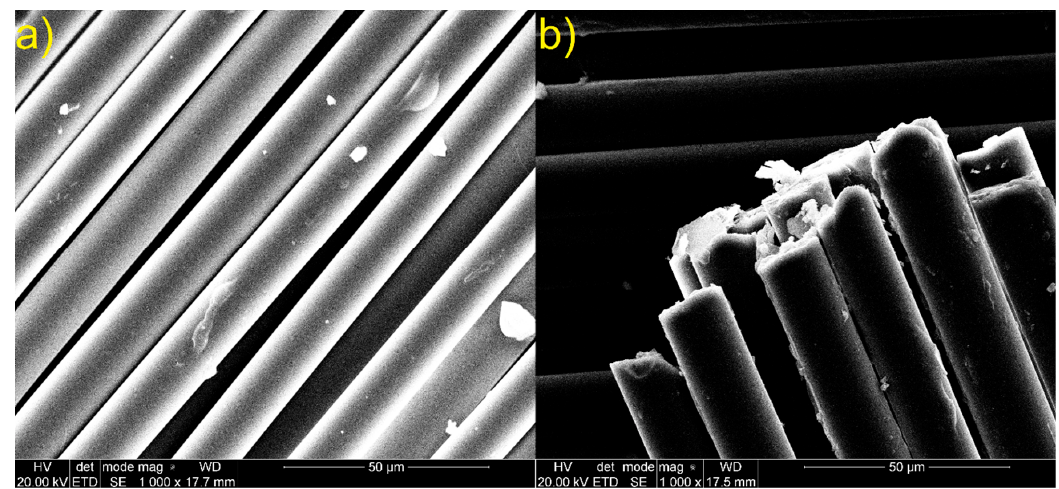
Figure 15. SEM images of glass fiber ( a ) lateral surface of glass fiber; ( b ) glass fiber ends. Materials 2020 , 13 , x FOR PEER REVIEW